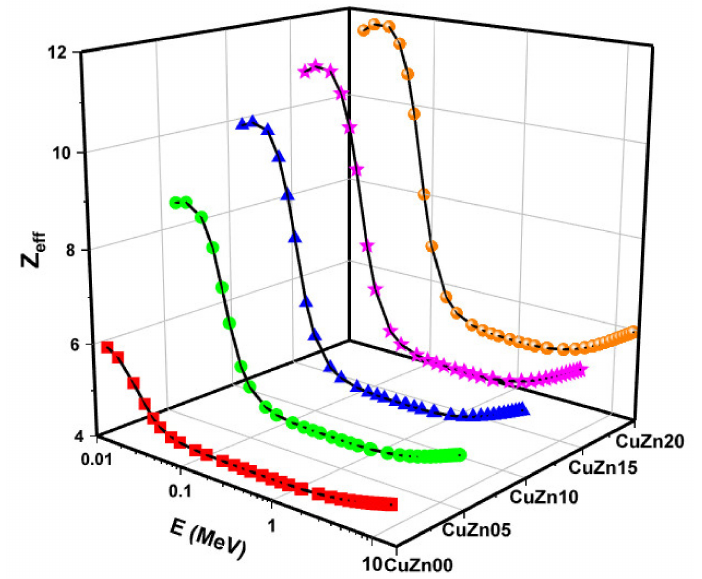
Figure 10. Effective atomic number (Z eff ) values as a function of photon energy and Cu-Zn content of